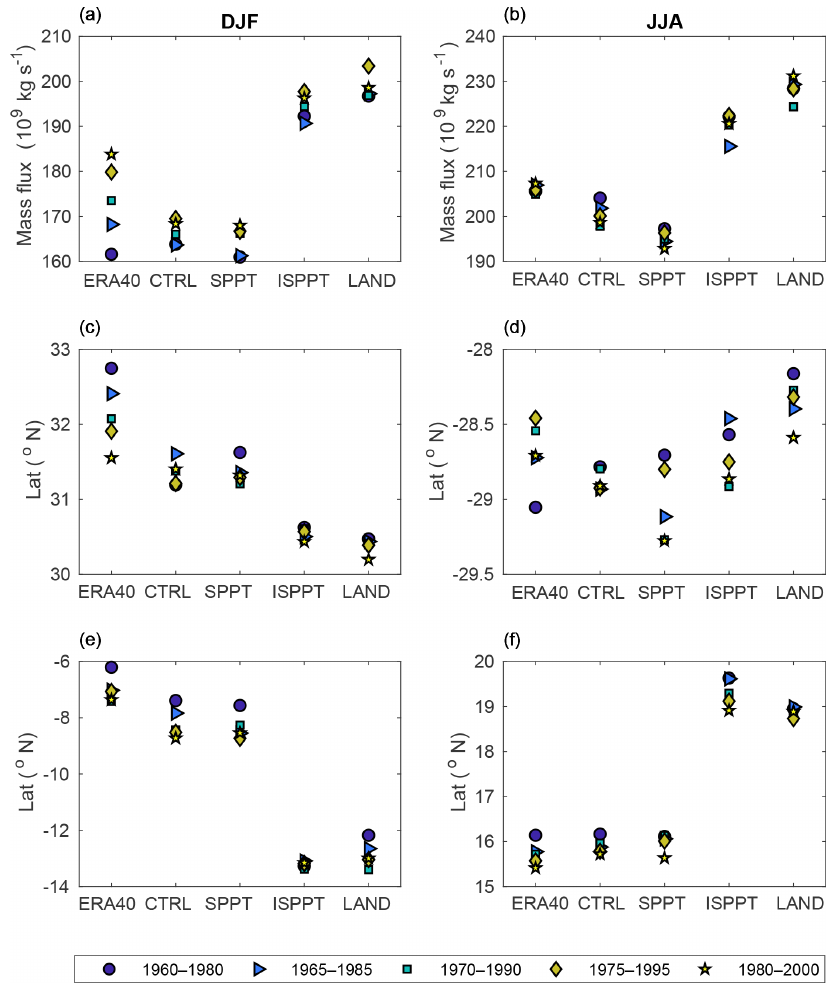
Figure 9. Impact of stochastic parameterizations on the Hadley circulation. The magnitude of the overturning circulation indicated by the maximum of the stream function of the dominant cell in (a) DJF and (b) JJA for each scheme. The latitude of the downwelling branch of the dominant (winter hemisphere) cell in (c) DJF and (d) JJA. The latitude of the upwelling branch of the dominant (winter hemisphere) cell in (e) DJF and (f) JJA. The data diagnostic is shown for each of the five AMIP simulations in turn, the darker colours indicate earlier years, ranging from dark blue (1960–1980) to yellow